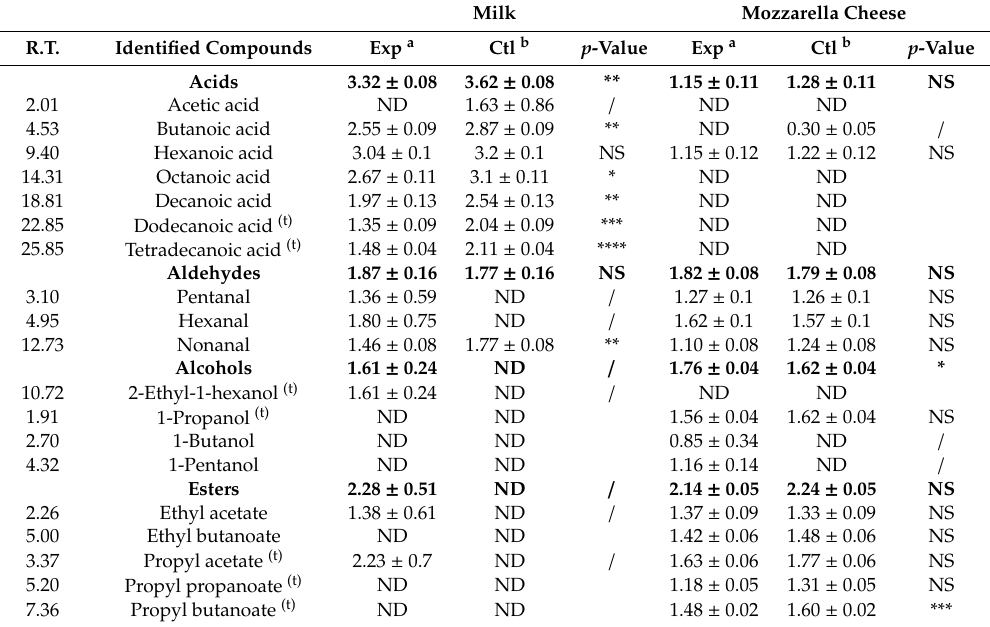
Table 3. Volatile organic compounds in milk (n = 9) and mozzarella cheese (n = 9) samples obtained from bu ff aloes fed total mixed ration with (Exp) or without (Ctl) fresh sorghum.